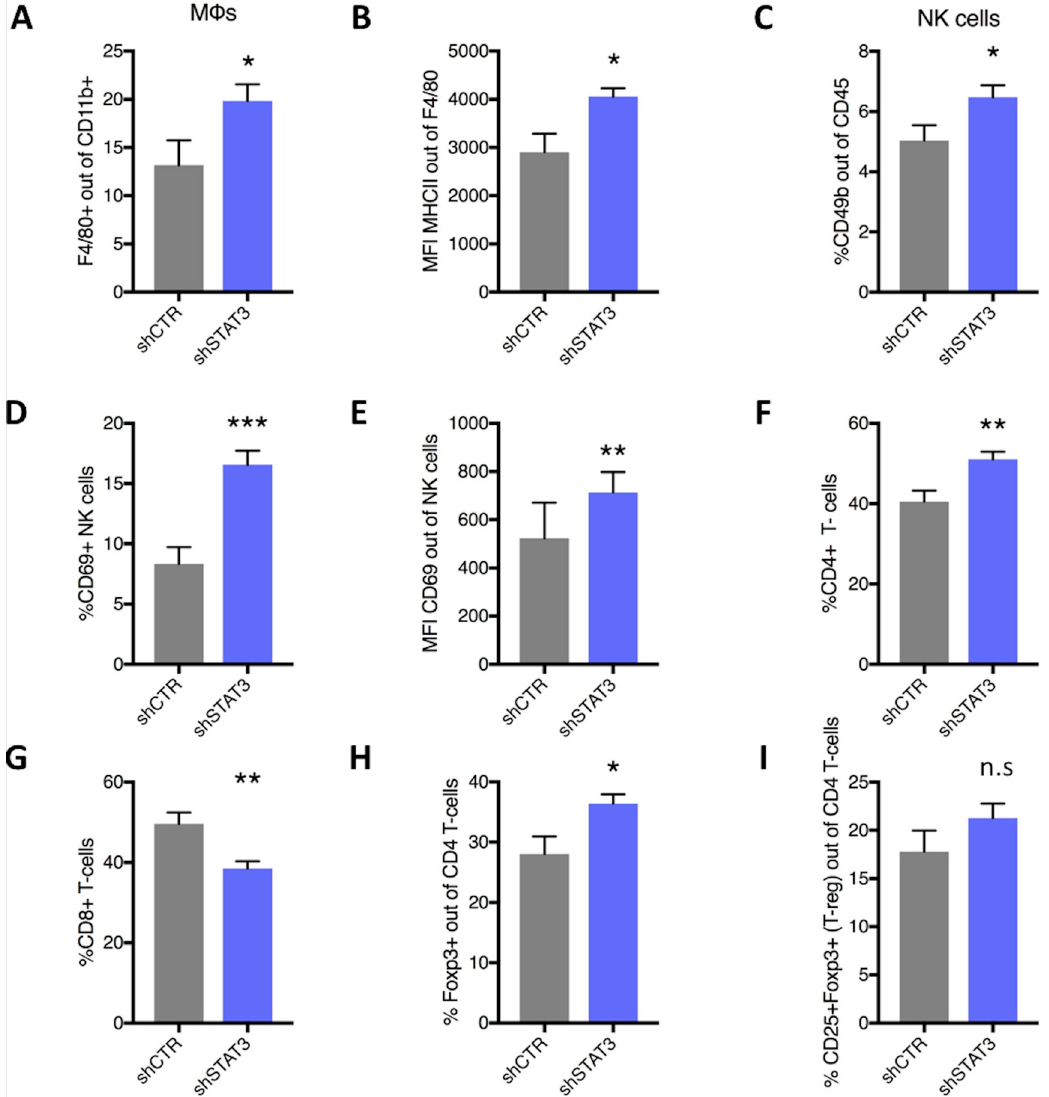
Figure 4. E ff ect of Stat3 silencing on immunologic profile in mouse model. 4T1-shCTRL and 4T1-sh Stat3 tumors were dissociated to a single cell level and analysed using flow cytometry for the percentage of ( A ). F4 / 80 + cells out of the gate of CD11b + . Graph ( B ) shows the mean fluorescence intensity (MFI) of MHCII out of F480 + cells in 4T1-shCTRL and 4T1-sh Stat3 tumors. ( C ) Percentage of CD49b + NK cells out of CD45 and percentage ( D ) and MFI ( E ) of CD69 out of NK cells in the same tumors. 4T1-shCTRL and 4T1-sh Stat3 tumors were also analysed with flow cytometry for the percentages of CD4 + T-cells ( F ), CD8 + T-cells ( G ), FoxP3 + ( H ) and CD25 + FoxP3 + cells out of CD4 + T-cells ( I ). Student’s t-test was performed for all comparisons depicted in the graphs and flow cytometry data are presented as mean ± SEM ( n = 8; * p < 0.05; ** p < 0.01; *** p < 0.001); MHC: major histocompatibility complex.